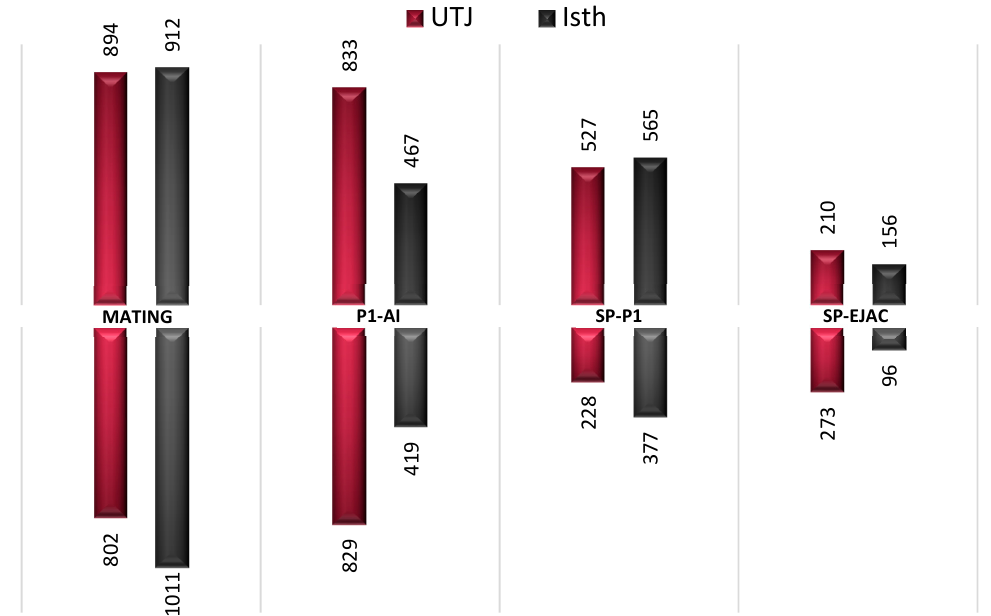
Figure 1. Differential expression (up- and down-regulation) of annotated genes. Treatment induced the differential expression of genes in all segments of the oviduct analyzed (Utero-tubal junction; UTJ, Isthmus; Isth). Mating: sow mated with a boar; P1-AI: sow artificially inseminated with the sperm-peak ejaculate portion (P1) extended to 50 mL with BTS; SP-Ejac: sow cervically infused with sperm-free seminal plasma of the whole ejaculate (50 mL); SP-P1: sow cervically infused with sperm-free seminal plasma from pooled sperm-peak portion P1 (50 mL). All treatments were compared to Control (AI with 50 mL of BTS). The numbers represent the number of differentially expressed genes ( p- value < 0.05).